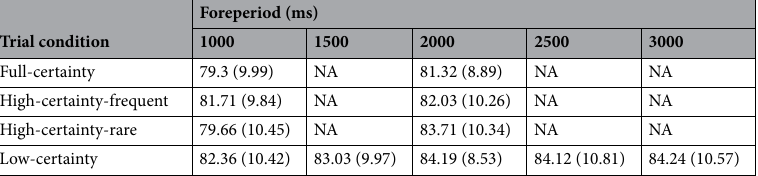
Table 2. Mean accuracy (%), averaged on the data of 20 participants separately for each condition and foreperiod. Standard deviations (%) are reported in parentheses. Trial conditions with no corresponding foreperiod marked as non-applicable